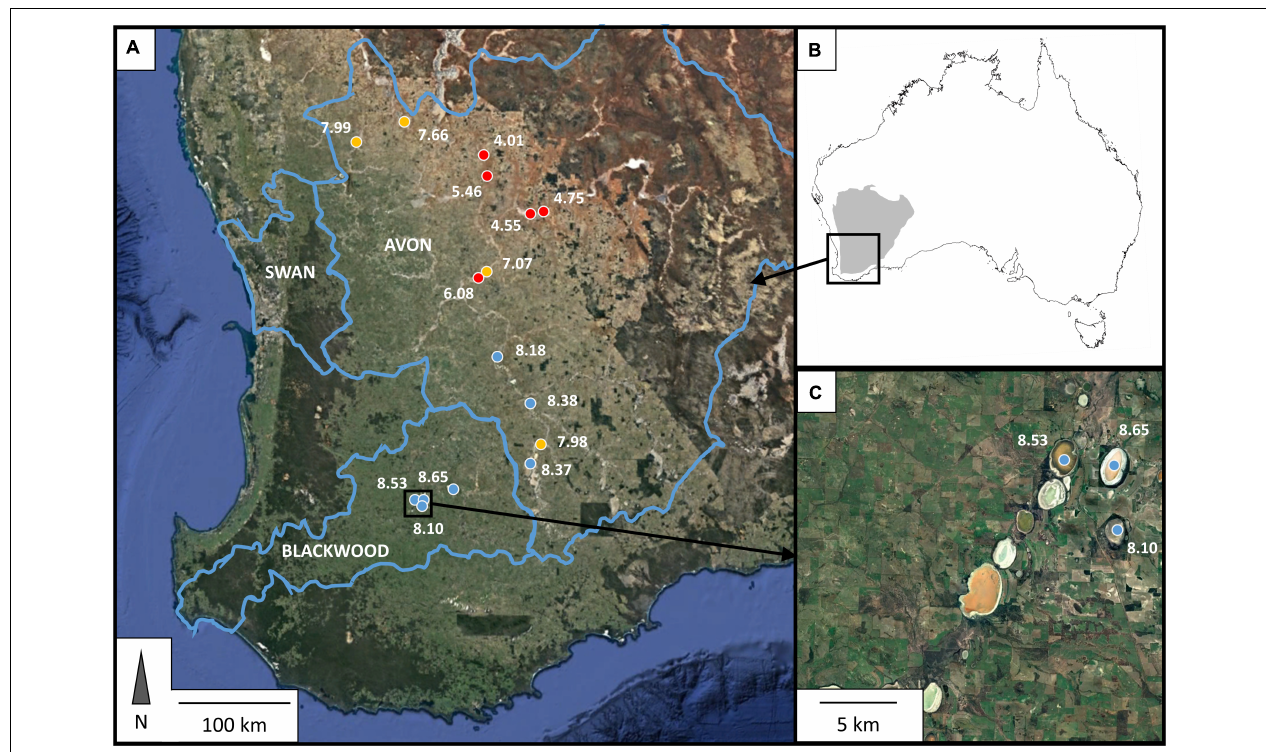
FIGURE 1 | Location of sampling sites within southwest Western Australia, indicated in (A) by colored dots, and (B) in relation to the continent of Australia (coast outlined in black) and the Yilgarn Craton, which underlies all sites sampled in this study. Three sites were located within 5 km of each other, as shown in panel (C) . Blue lines indicate the boundaries of major regional catchments (Geoscience Australia, 1997); names of the catchments are indicated within these boundaries in white capitalized text. Colored dots in (A,C) designate different observed pH values: pH < 7—red; 7 ≤ pH ≤ 8—yellow; pH > 8—blue, with exact value of observed pH at the time of sampling shown in white numbers next to each site